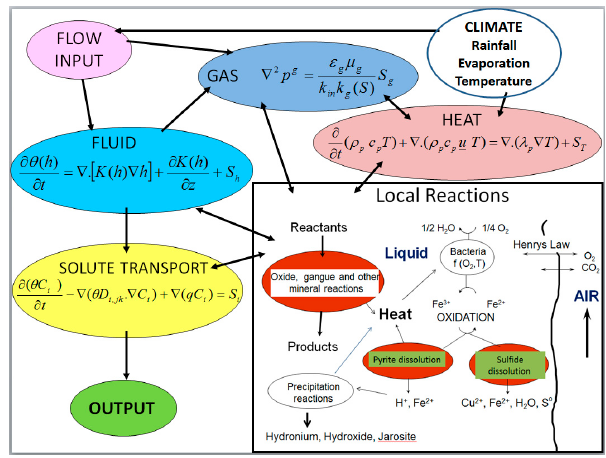
Figure 2. CFD model structure and coupling.